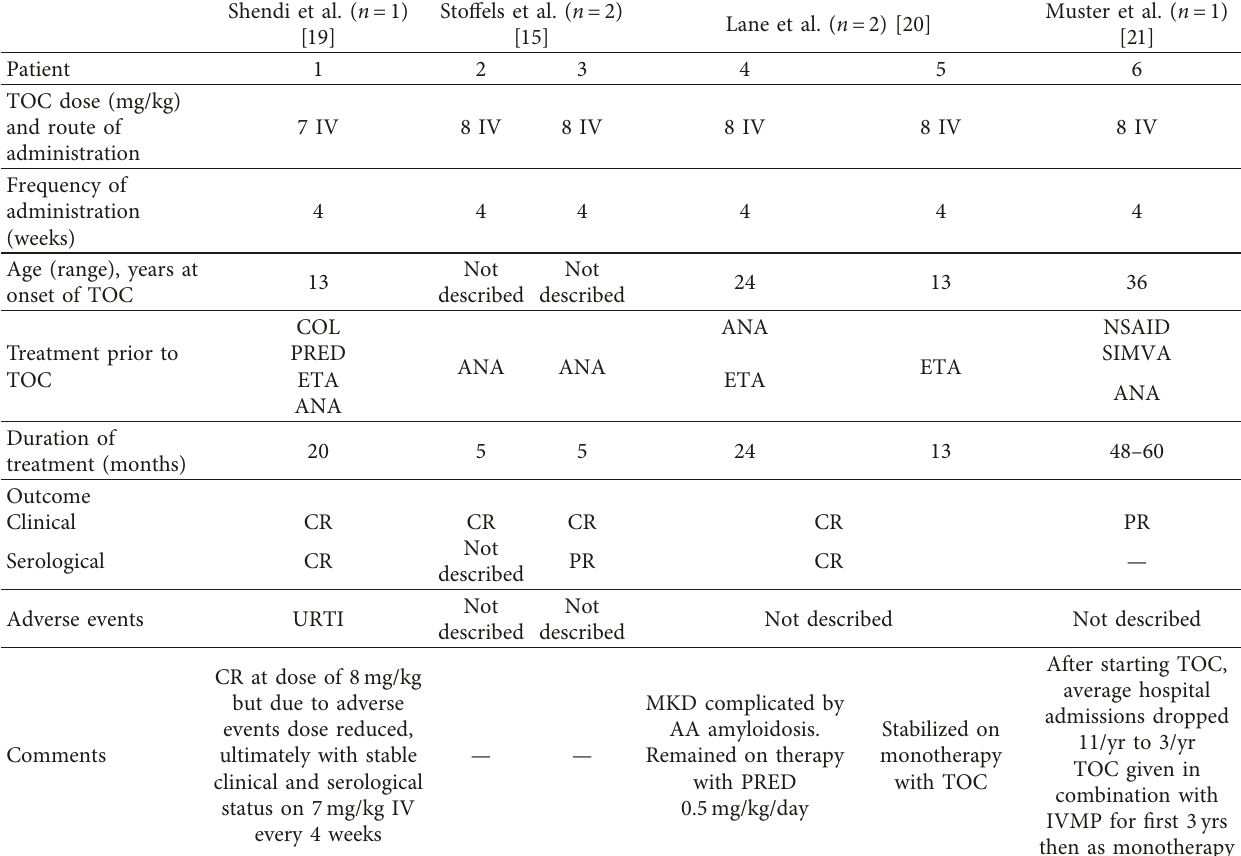
Table 1: Previous reports of tocilizumab for the treatment of